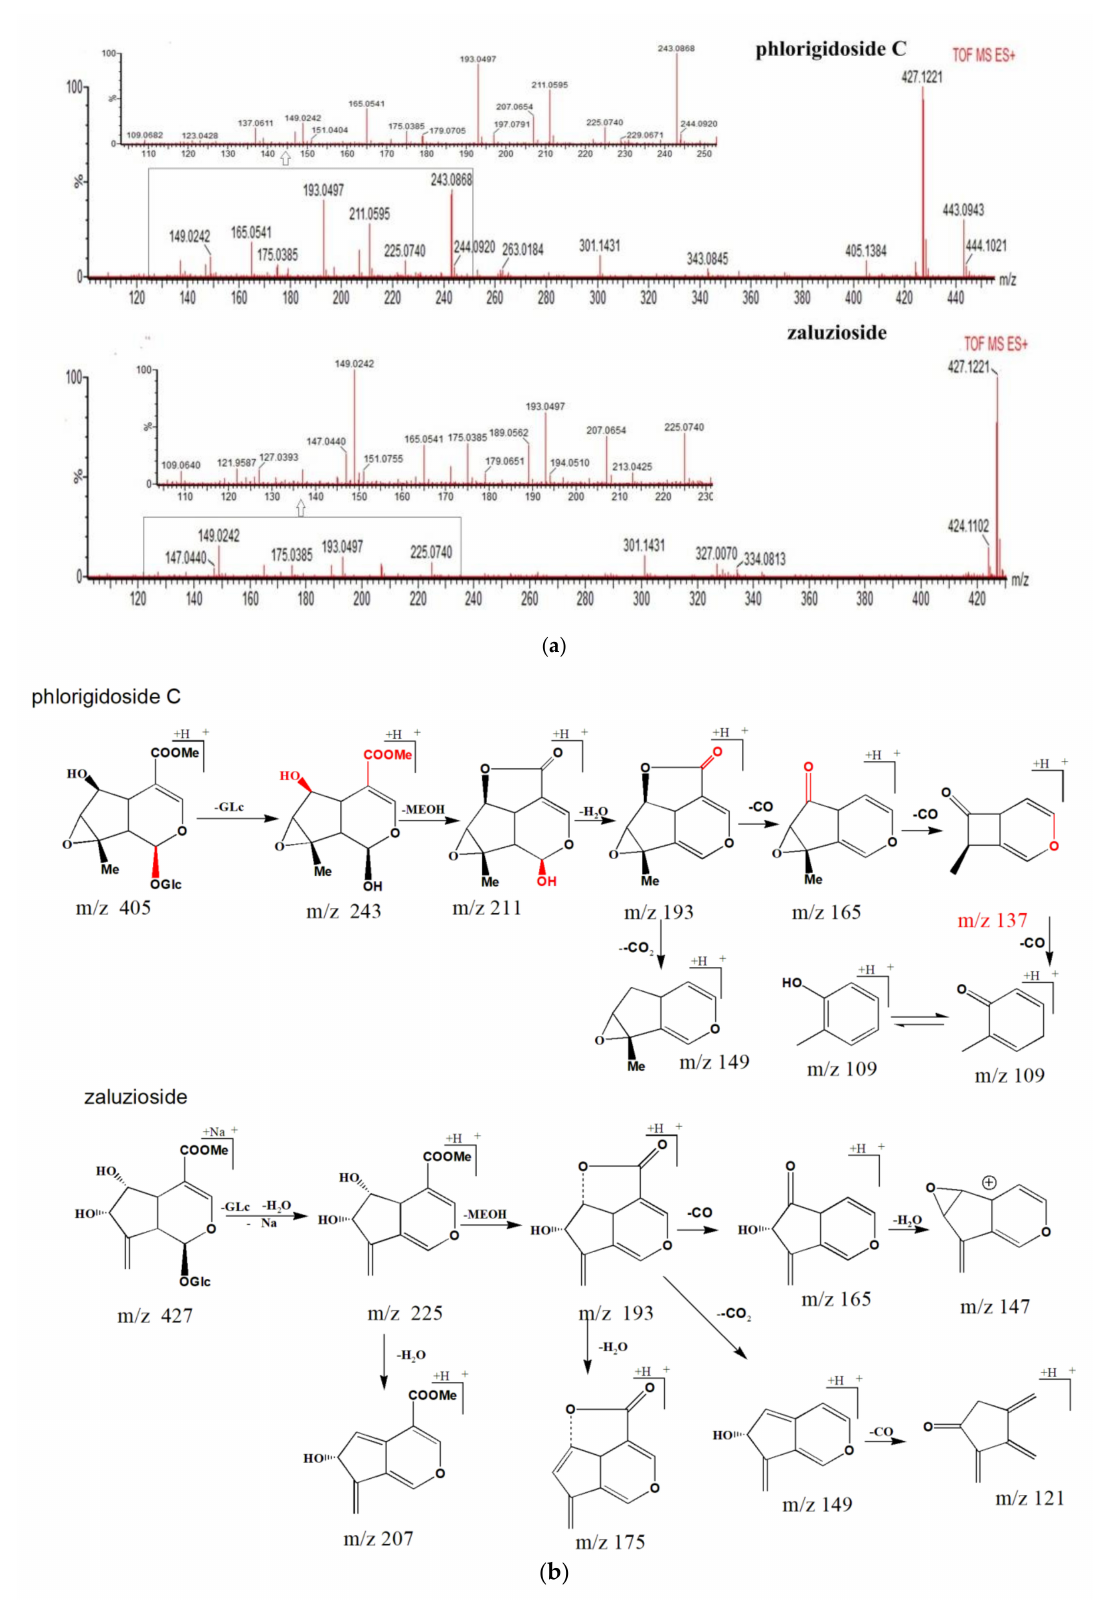
Figure 4. ( a ) MS 2 spectra of phlorigidoside C and zaluzioside. ( b ) Possible mass fragmentation pathways of phlorigidoside C and